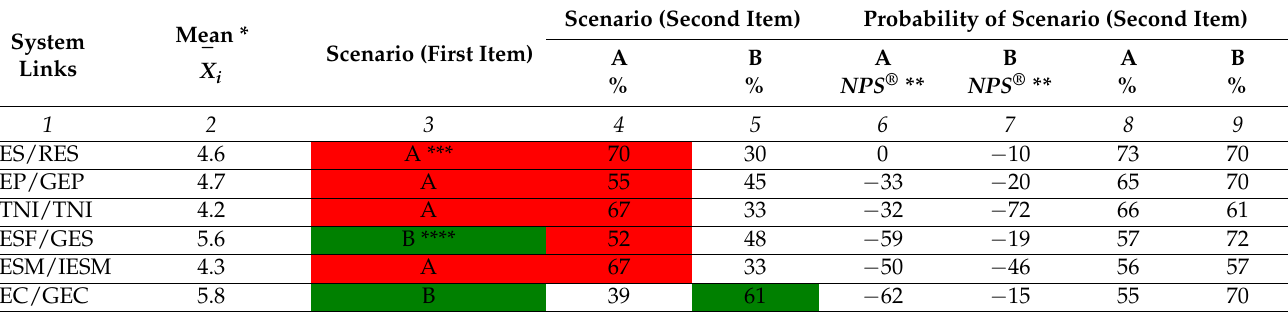
Table 3. Aggregated expert